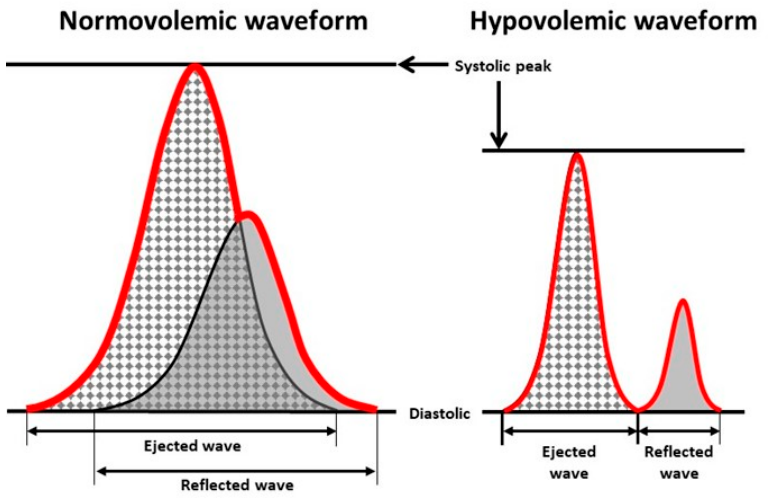
Figure 2. Illustration of changes in features of the ejected and reflected arterial waveforms progressing from a normal blood volume state to a state of reduced central blood volume (i.e., hypovolemia) such as that experienced during hemorrhage. The red line indicates the integrated waveform that is clinically observed. Modified from Convertino et al. [14,22,23].